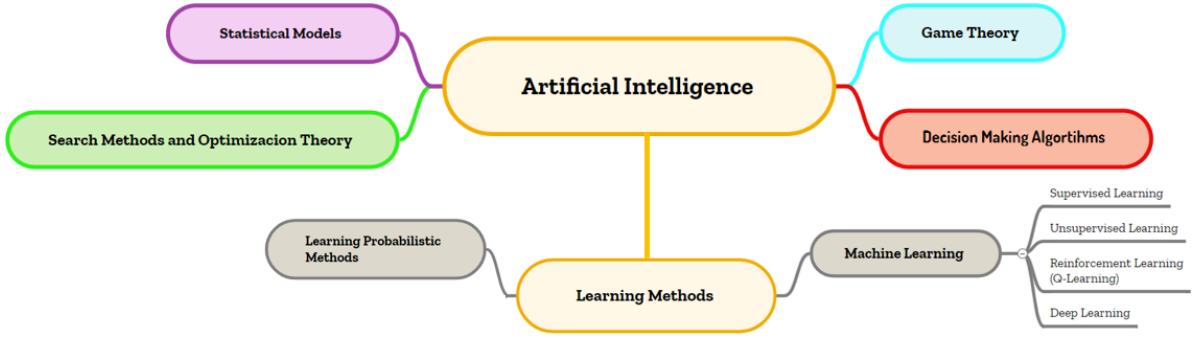
Figure 7. Classification of forecasting methods based on AI.